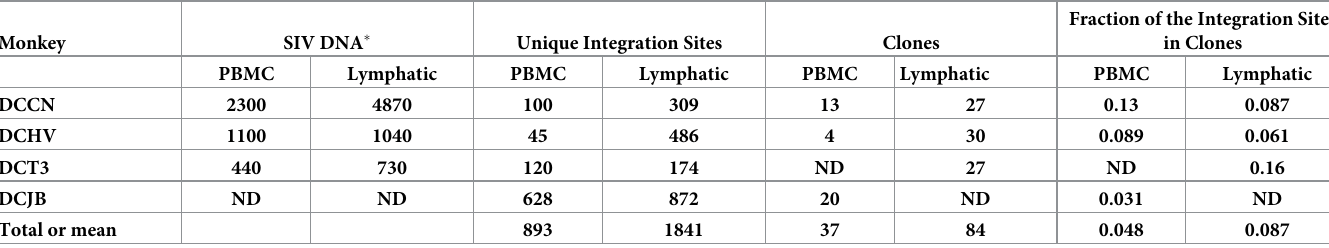
Table 10. On-therapy viral DNA and integration sites.